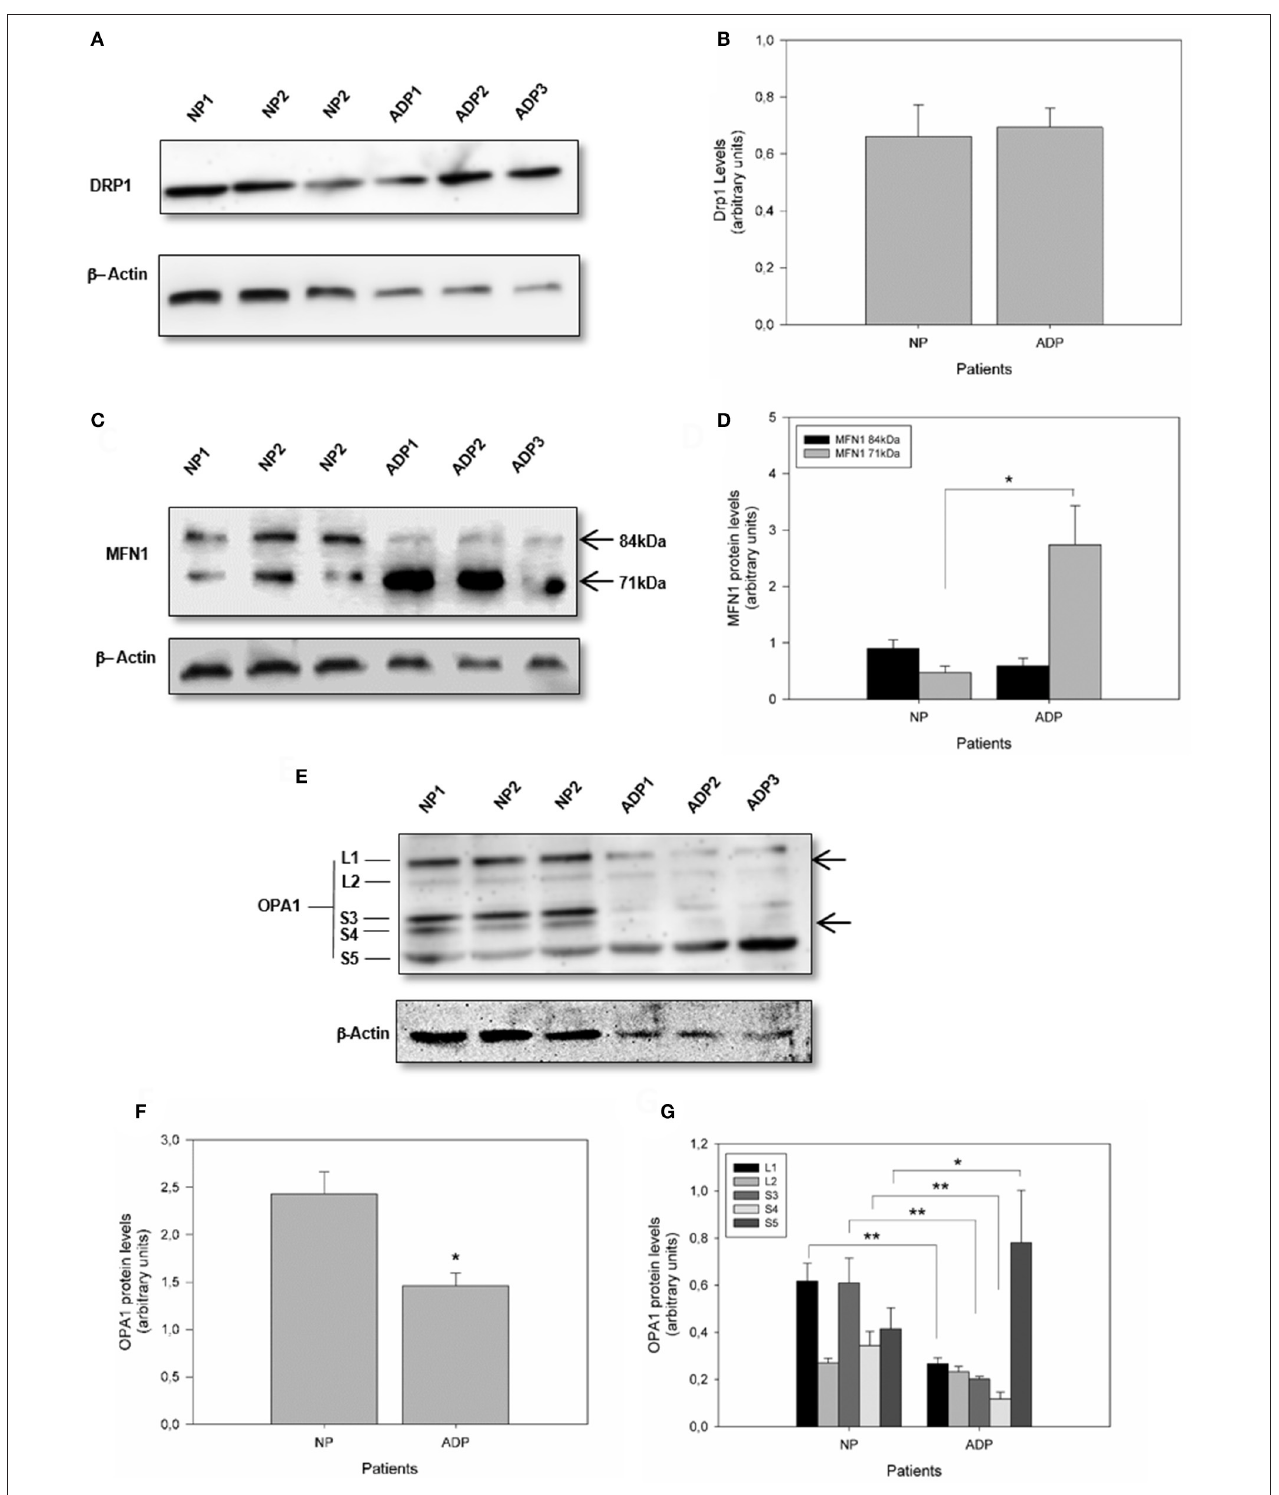
FIGURE 2 | Defects in mitochondrial fusion regulation in fibroblasts obtained from AD patients. (A) The levels of mitochondrial fission protein DRP1, in AD and control patients were determined by Western blot (see Methods). (B) Quantitative analysis of DRP1 relative expression. Data are mean ± SE. (C) Levels of mitochondrial fusion protein MFN1 are indicating the protein splicing variants (arrows). (D) Quantification of the MFN1 splicing products. * p < 0.05 indicates differences between groups calculated by Student t -test, data are mean ± SE. (E) Levels of mitochondrial fusion protein OPA1 showing isoforms and proteolytic products of OPA1 (arrows). (F,G) Quantification of OPA1 content and isoforms pattern. * p < 0.05, ** p < 0.01 indicate differences between groups calculated by Student t -test, data are mean ± SE.